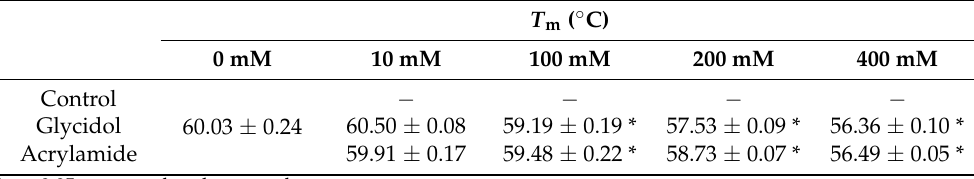
Table 2. Melting temperature of hemoglobin exposed to glycidol or acrylamide.